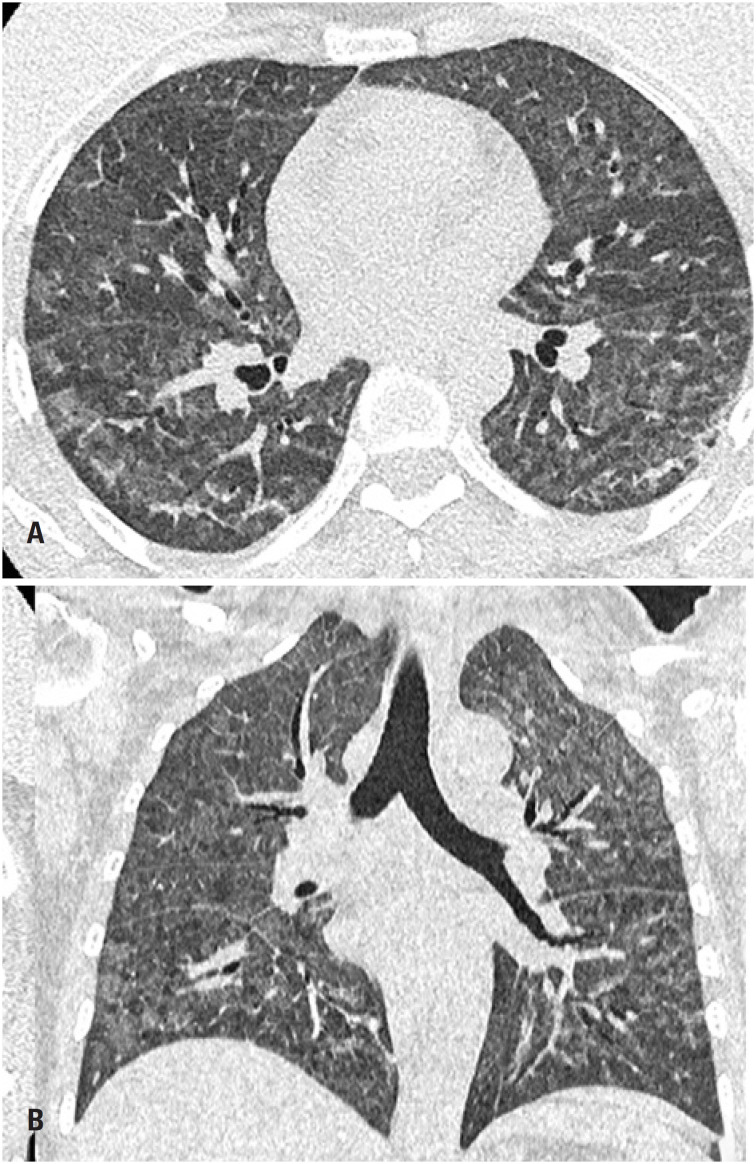
Mulher, 46 anos, com queixa de tosse produtiva. Refere antecedente de AIDS. Tomografia computadorizada (A) Com corte axial (B) Reformatação coronal: extensas opacidades acometendo difusamente os campos pulmonares, com padrão heterogêneo em vidro fosco associado a discreto espessamento septal. Não há consolidação pulmonar